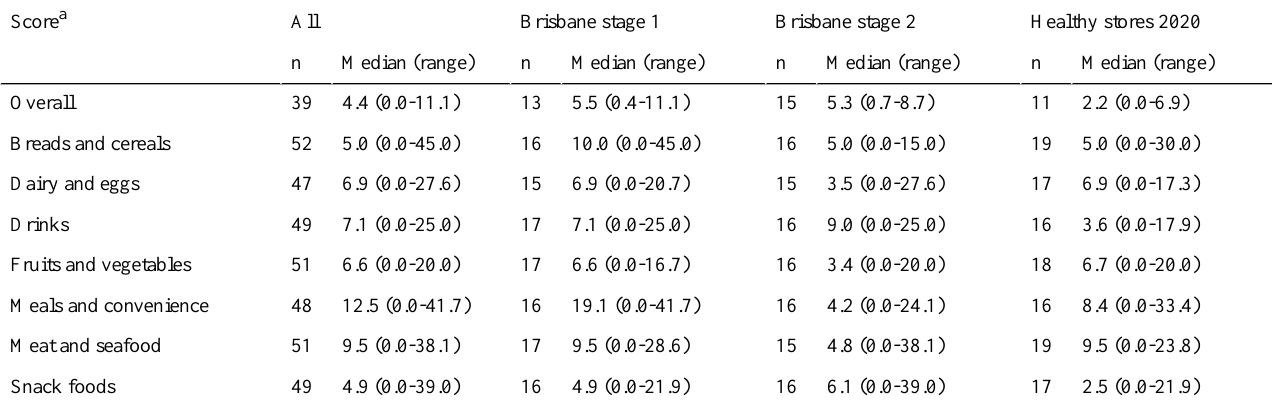
Table 3. Score difference between surveyors by category and